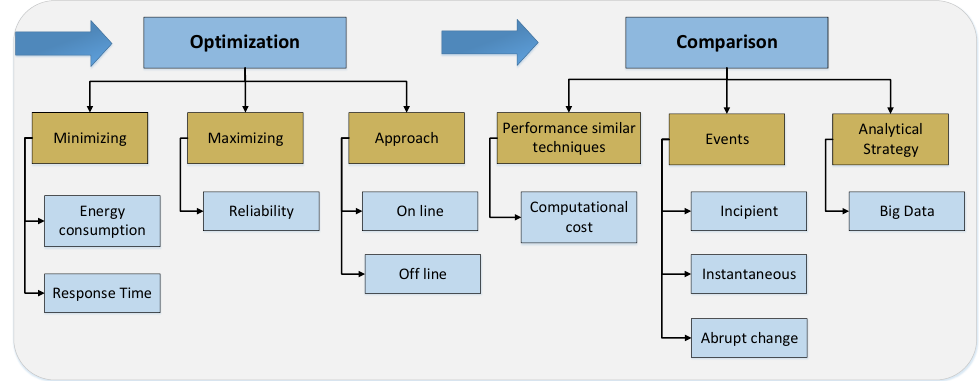
Figure 3. Comparison between a system with centralized and distributed